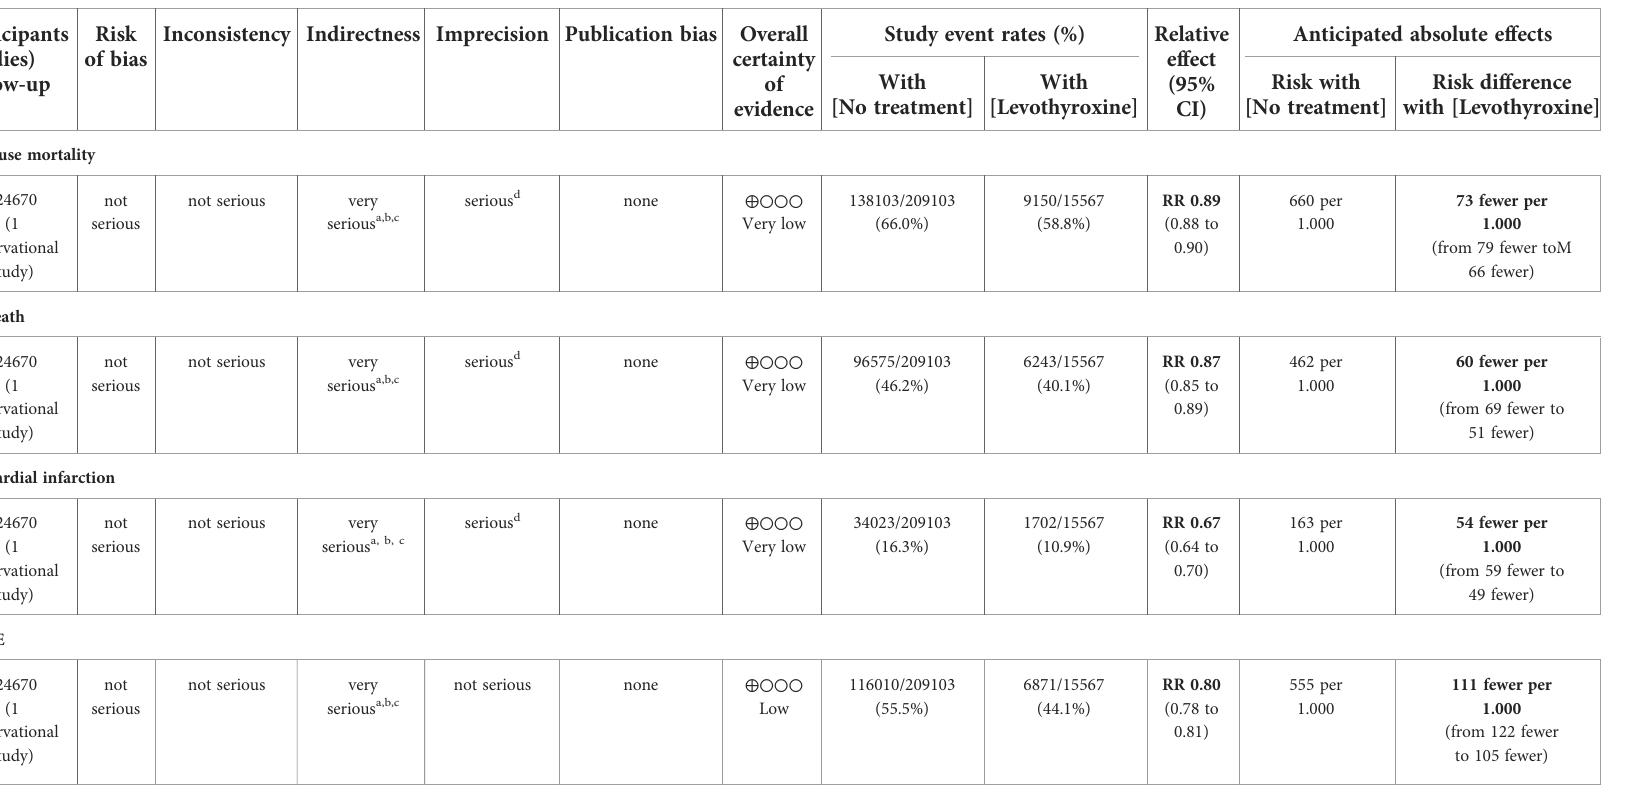
TABLE 4 Levothyroxine versus no treatment for improving CV outcomes in patients with SCH and CHF (Einfeldt MN, et al.,